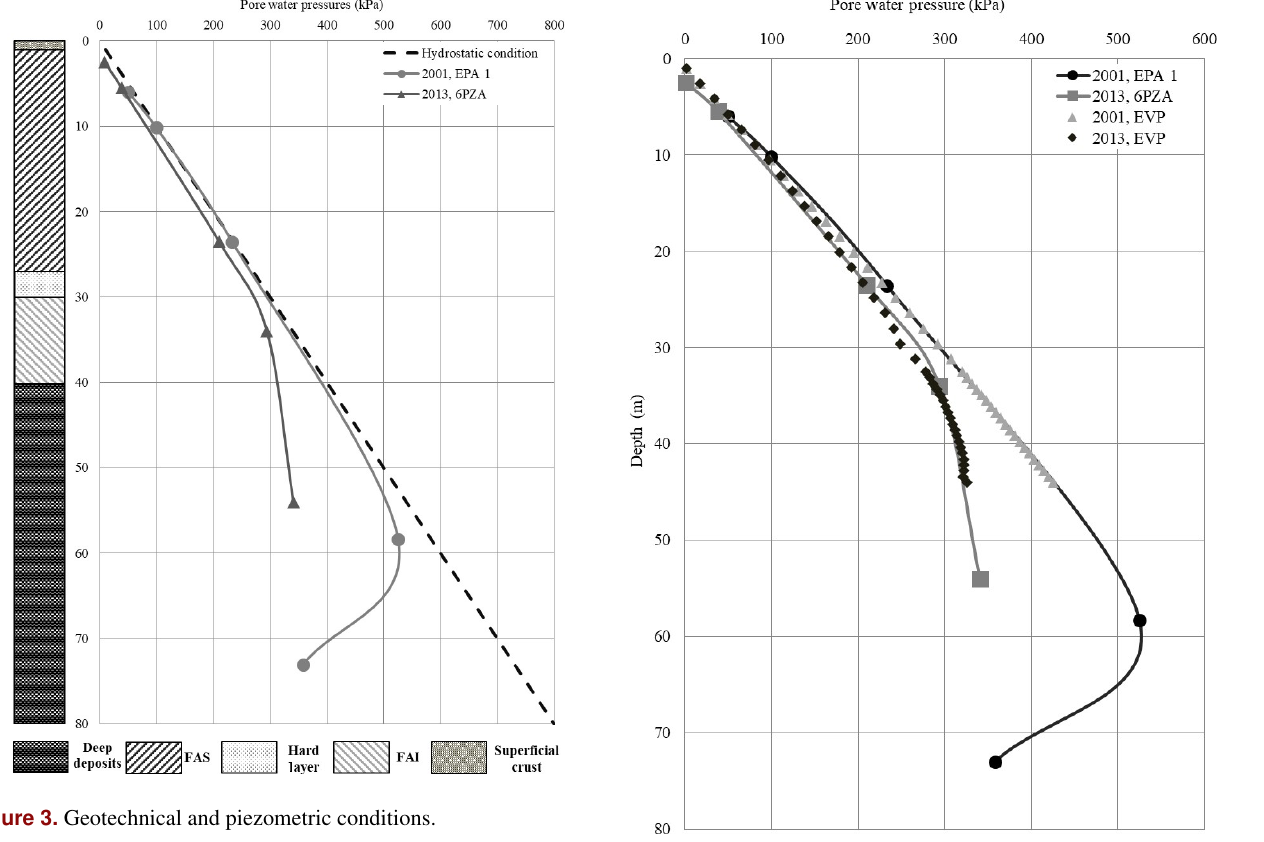
Figure 4. Measured and simulated pore pressures. Table 2. Geotechnical properties at the site